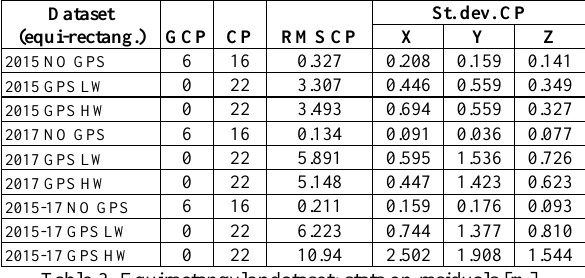
Table 3. Equirectangular dataset: stats on residuals [m]. Dataset tie points (planar) n.